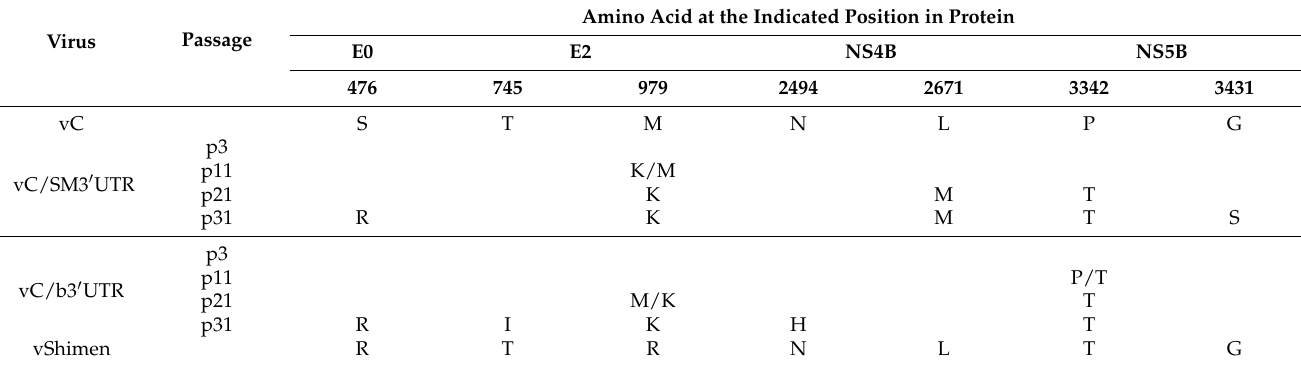
Table 2. Amino acid mutations in the continuous passages of two 3 (cid:48) UTR substituted chimeric viruses. Amino Acid at the Indicated Position in Protein Virus Passage E0